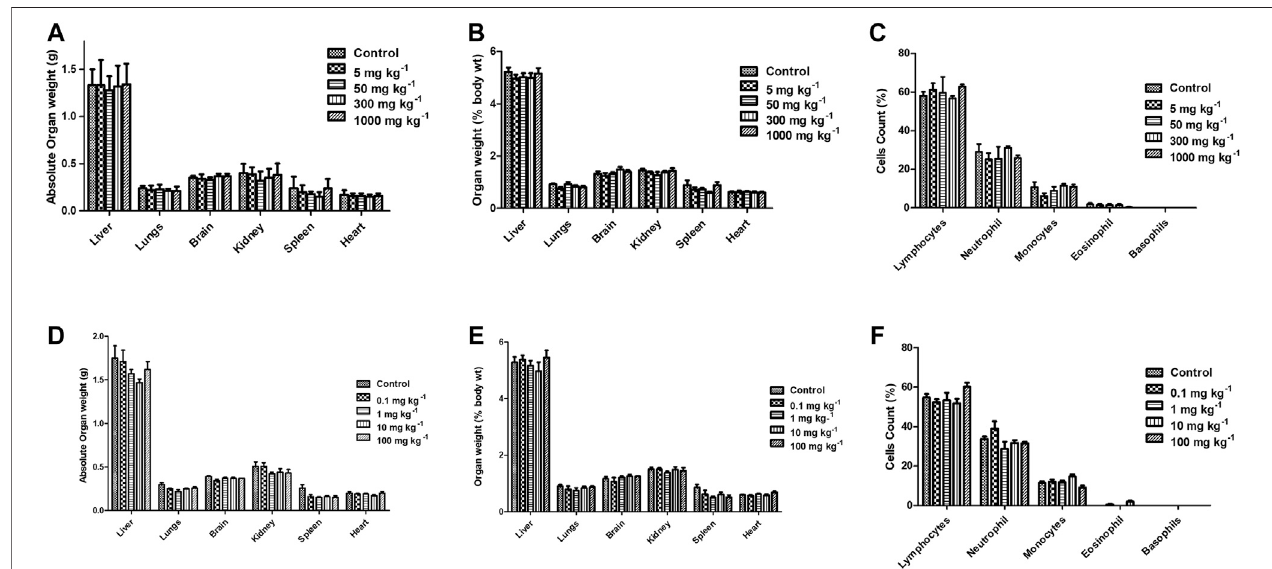
FIGURE11| EffectofFPDasasingleacuteoraldoseat5,50,300,and1,000 mg kg − 1 onabsoluteorganweight,relativeorganweight,anddifferentialleukocytes count (DLC) (A – C) in Swiss albino mice (mean ± SEM, n (cid:2) 6). Effect of FPD as sub-acute oral dose at 0.1, 1, 10, and 100 mg kg − 1 once orally for 28 days on absolute organ weight, relative organ weight, and DLC (D – F) in Swiss albino mice (mean ± S.E.M., n (cid:2)